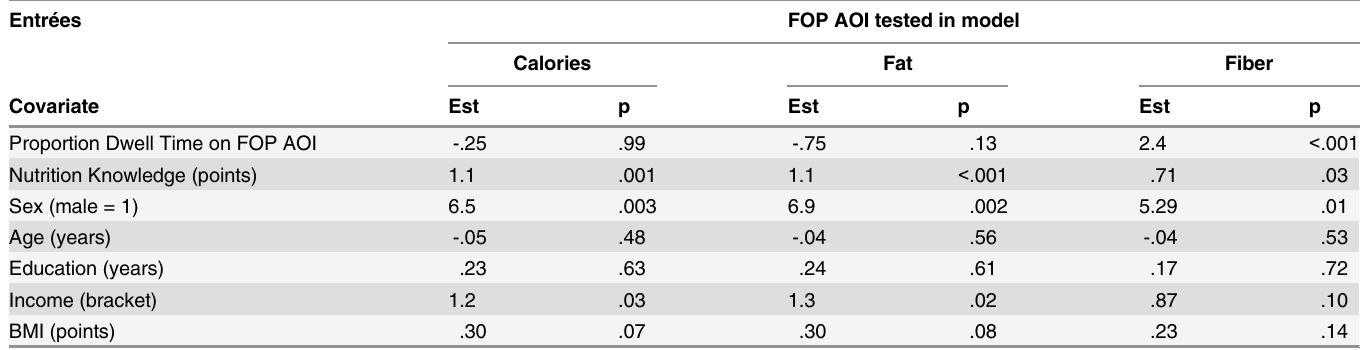
Table 5. Estimated effects of dwell time on accuracy, tested separately for each area of interest (AOI) for entrées, and adjusted for covariates.